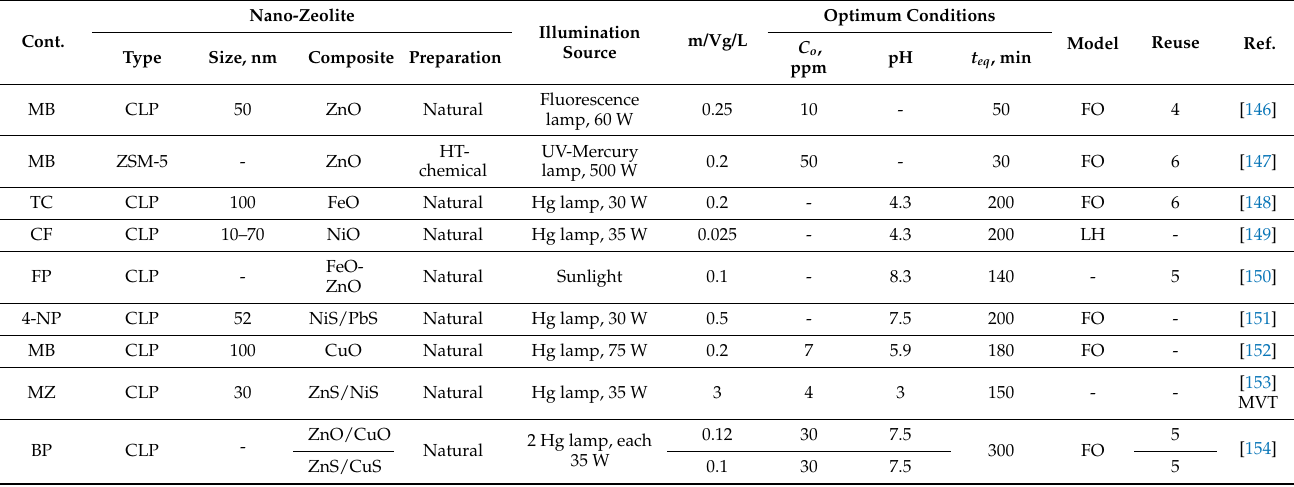
Table 8. Results of the applications of nano-zeolite composite for photo-catalytic degradation of organic